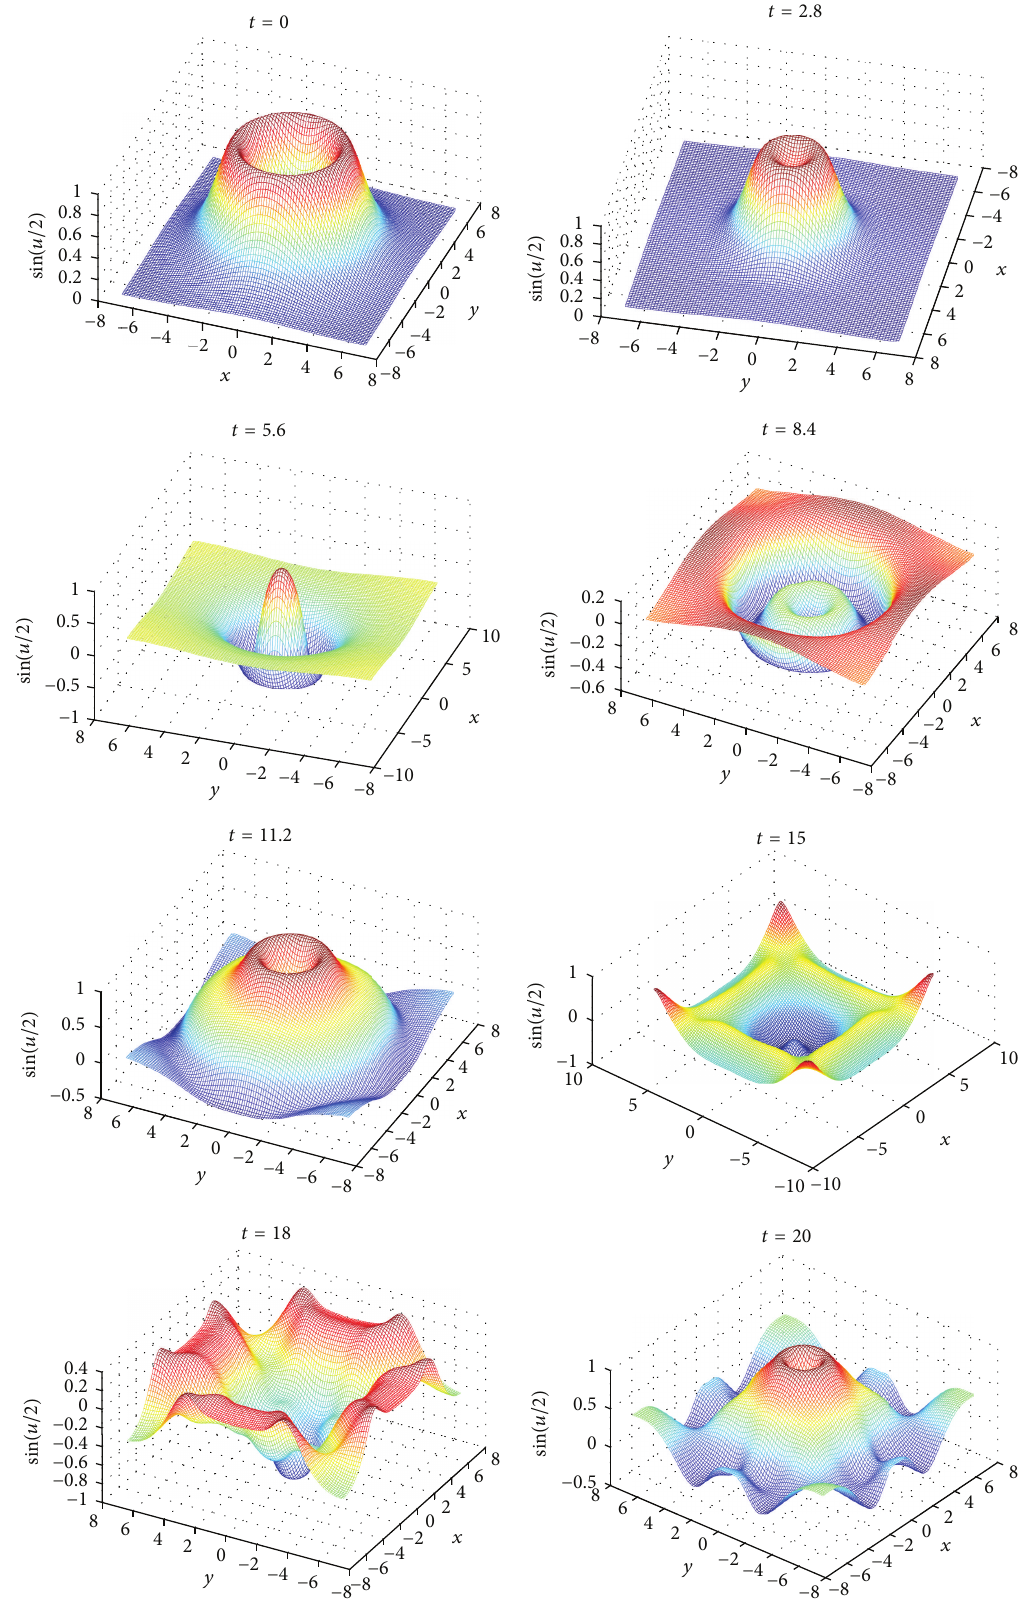
Figure 5: Circular ring solitons solution at 𝑡 = 0, 2.8, 5.6, 8.4, 11.2, 15, 18, 20 with 𝜌 = 0